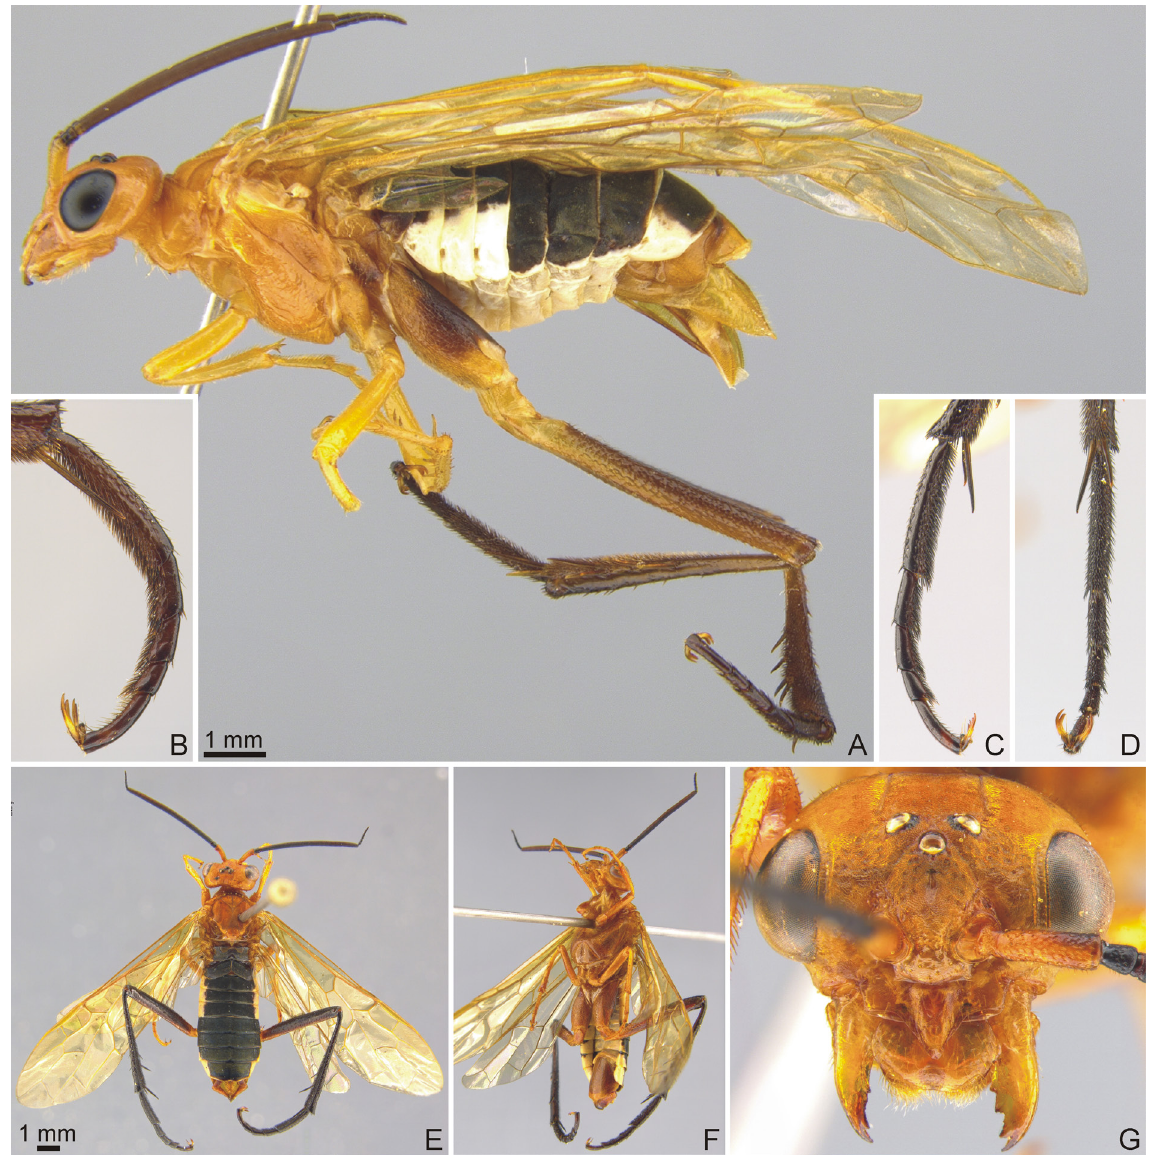
Fig. 4. Megaxyela fulvago Blank, Shinohara & Wei sp. nov. A . Habitus lateral (♀, DEI-GISHym